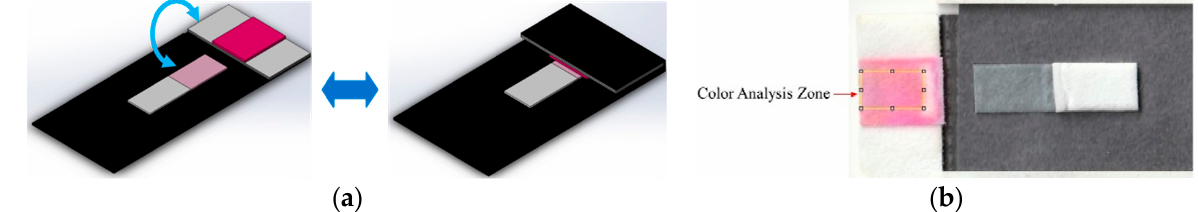
Figure 4. ( a ) The detection zone is folded over the G1 pad for 10 min. ( b ) Color analysis zone used in ImageJ to quantify the color intensity; this area is 105 by 175 pixels, which is approximately 4.5 by 7.5 mm.